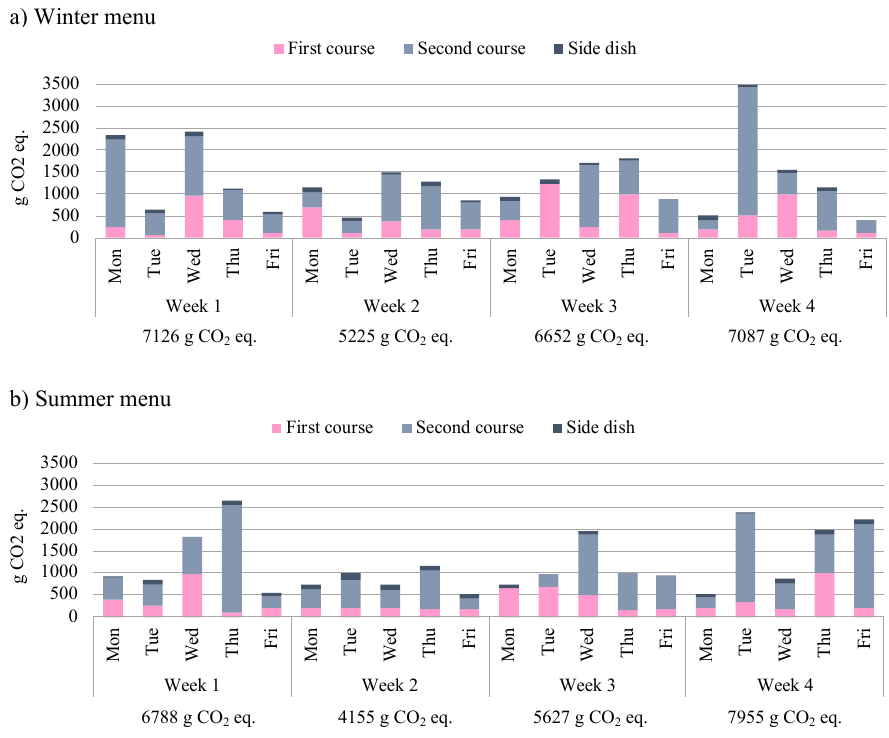
Figure 2. Carbon Footprint of the winter ( a ) and the summer ( b ) menu analysed.